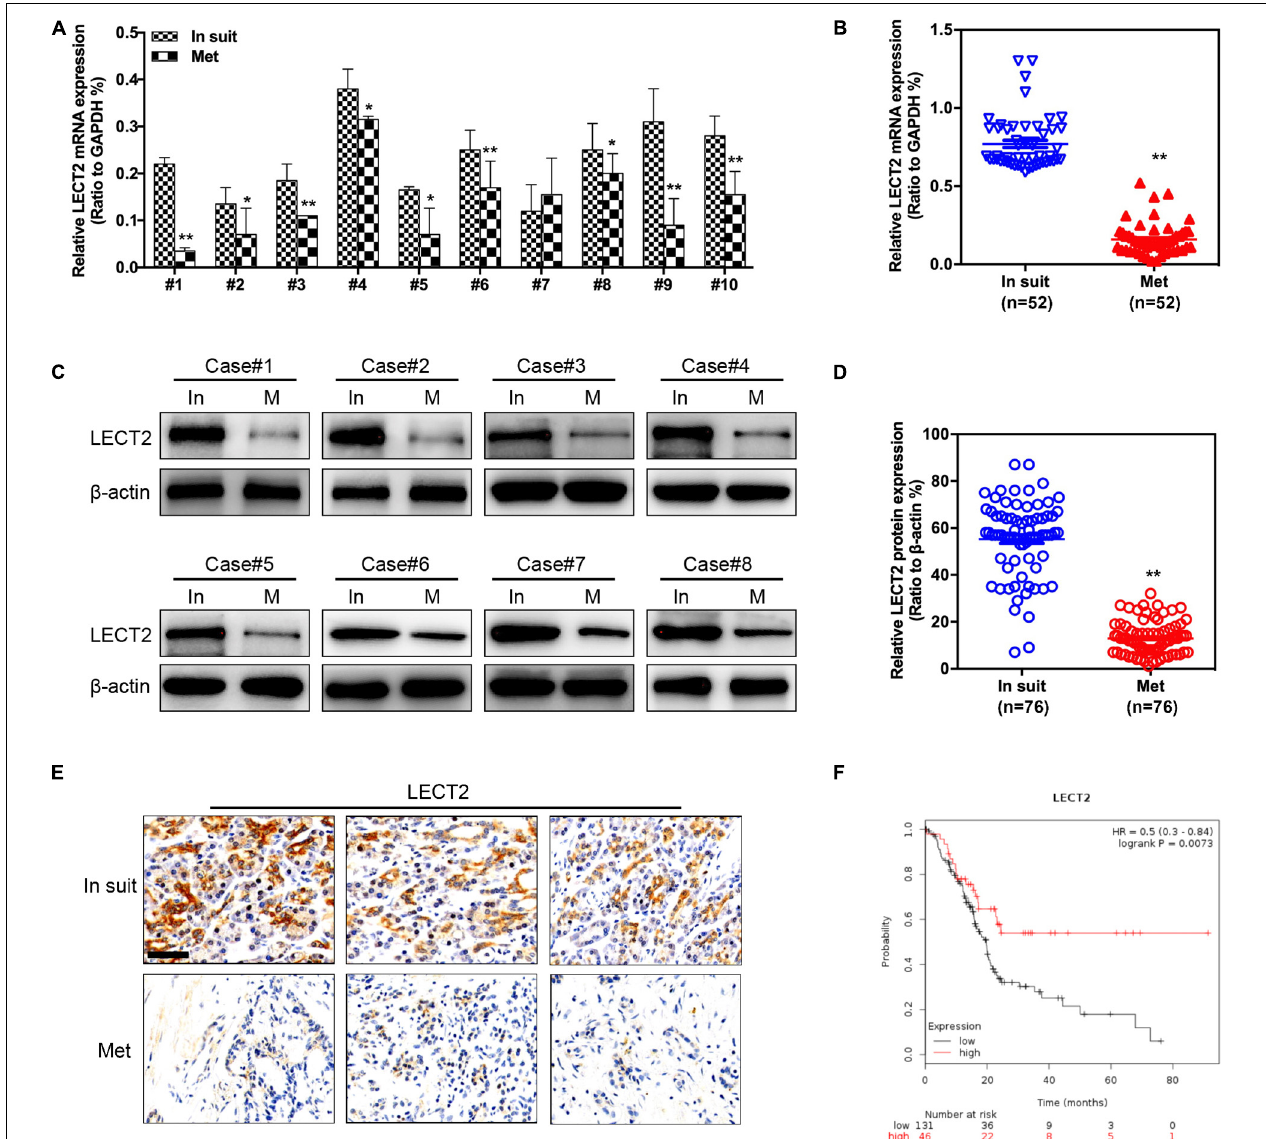
FIGURE 1 | LECT2 expression in primary ( in situ ) and metastatic (Met) PDACs. (A) Representative qRT-PCR results of LECT2 expression in paired primary and metastatic (Lymph node metastasis) PDACs. (B) Quantification of qRT-PCR results in paired primary ( n = 52) and metastatic ( n = 52) PDACs. (C) Representative immunoblotting results of LECT2 protein levels in paired primary and metastases (Lymph node metastasis) PDACs. (D) Quantification of immunoblotting results in paired primary ( n = 76) and metastatic ( n = 76) PDACs. (E) Representative images of immunohistochemistry (IHC) staining for LECT2 in sections from paired primary and metastatic PDACs (Scale bar: 100 µ m). (F) Kaplan-Meier analysis indicating the overall survival of PDAC patients with low (black) or high (red) LECT2 expression. * p < 0 . 01 and ** p < 0 .